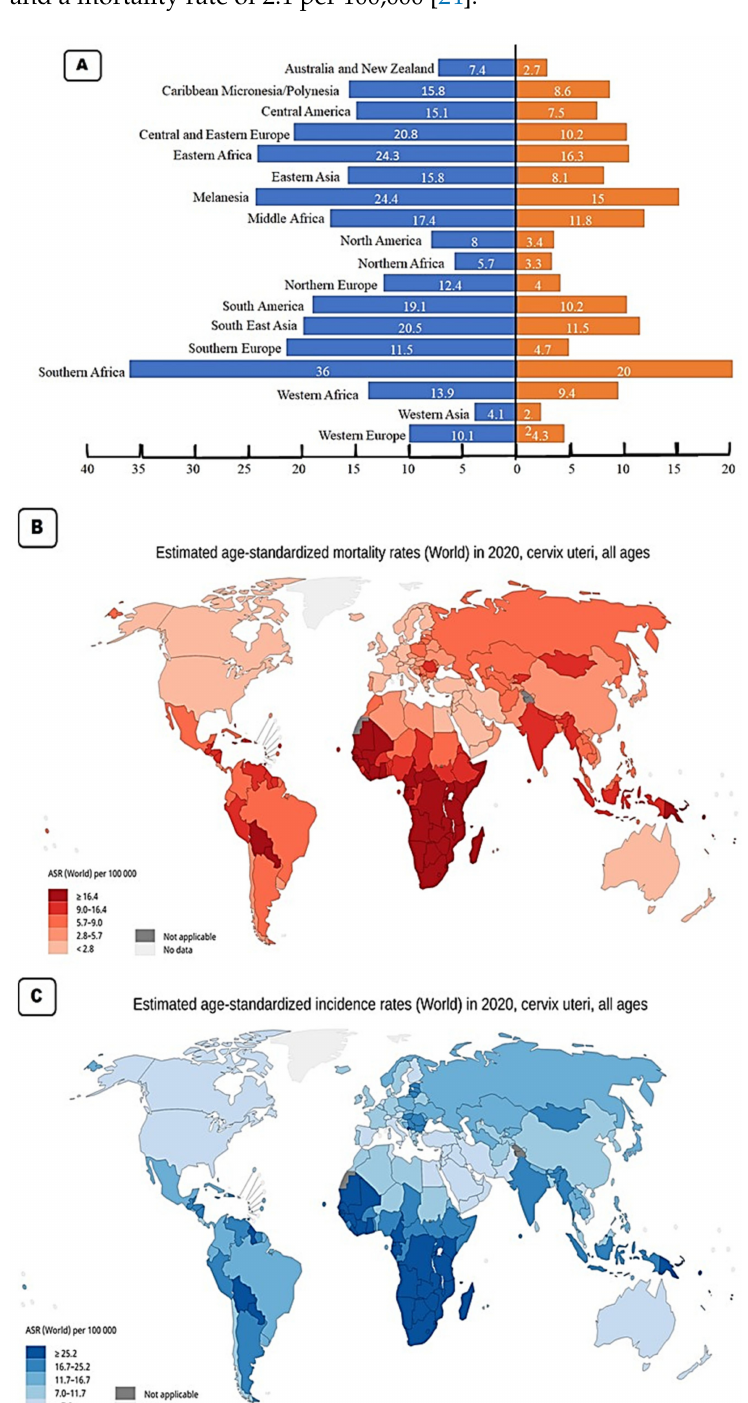
Figure 2. ( A ) Age standardised rates (ASR) (per 100,000 women per year) incidence and mortality for cervical cancer in specific regions. ( B ) Map showing the age standardised rate (ASR) for incidence in individual countries. ( C ) Map showing the age standardised rate (ASR) for mortality in individual countries